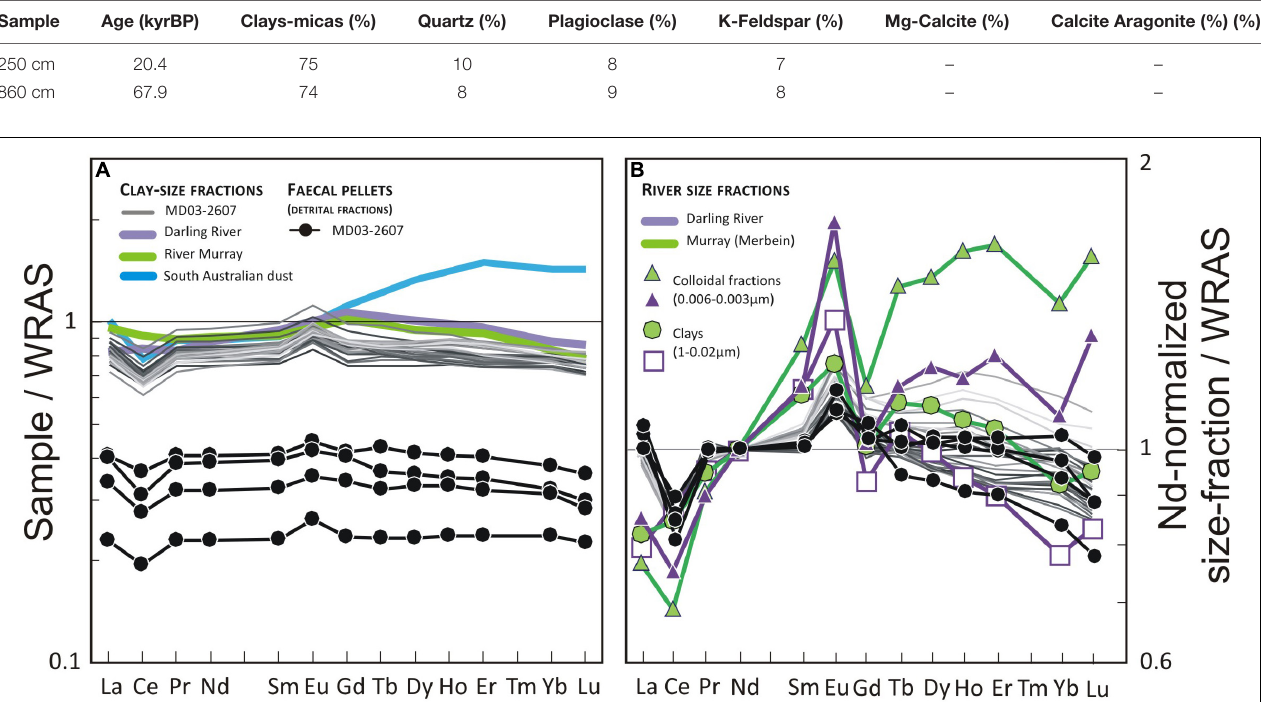
TABLE 3 | Mineralogical composition of fine-grained detrital fractions (core MD03-2607).